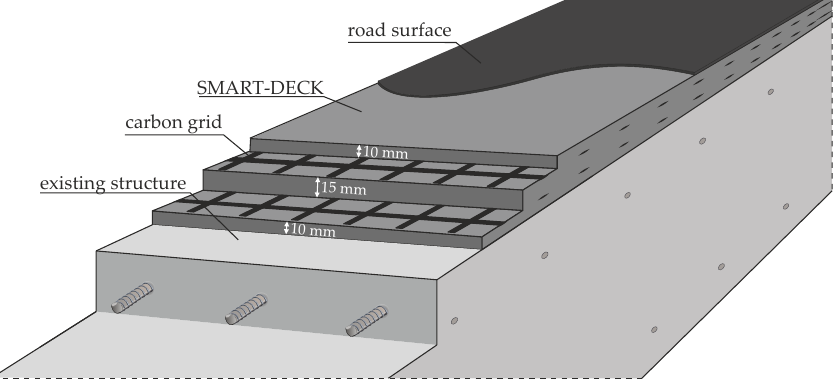
Figure 3. Virtual saw cut as schematic sketch of the strengthening layer on a RC